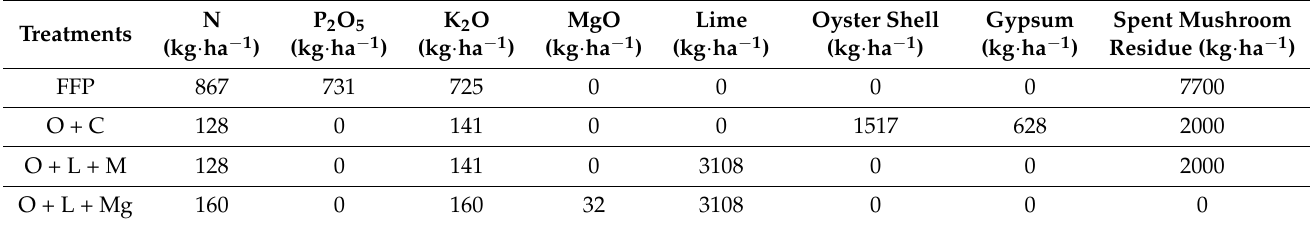
Table 1. Fertilizer application amount under different